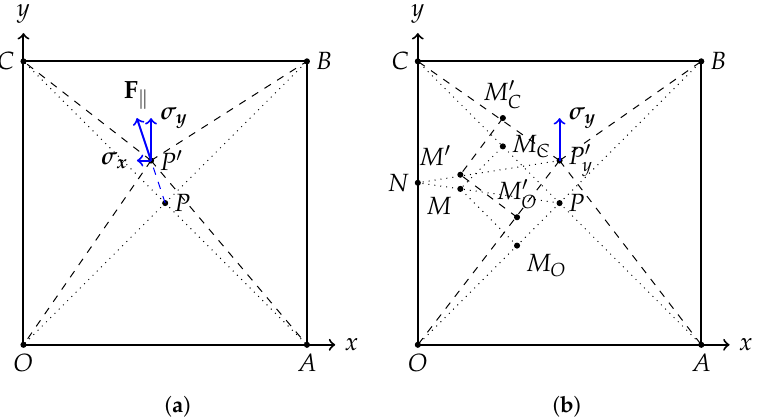
Figure 5. Deformation of PDMS film as a linear elastic material with external shear force applied. ( a ) An arbitrary applied shear force F (cid:107) can be divided orthogonally. ( b ) P is the point where shear force σ y is applied in y direction, moving P to P (cid:48) , together with M , M O , and M C moving to M (cid:48) , M (cid:48) and M (cid:48) , respectively. Both lines PM and P (cid:48) y M (cid:48) intersect with OC at point N C